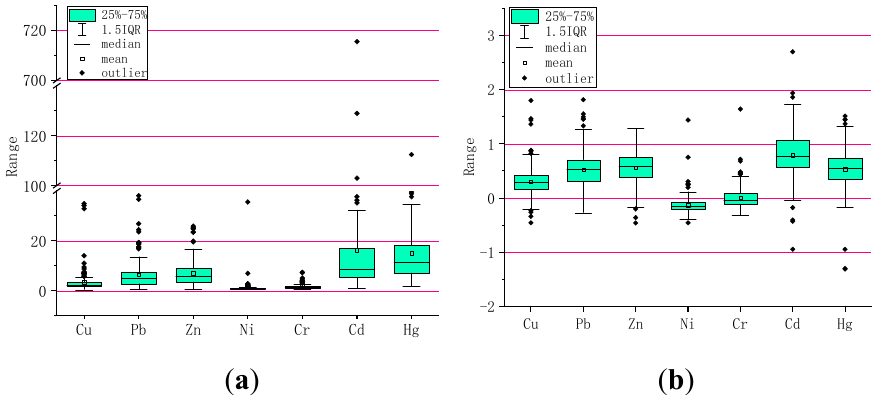
Figure 4. ( a )Enrichment factors (EF) and ( b )Geoaccumulation index (Igeo) boxplots for heavy metals Figure 4. ( a ) Enrichment factors (EF) and ( b ) Geoaccumulation index (Igeo) boxplots for heavy metals associated with dust particles smaller than 74 µm. associated with dust particles smaller than 74 µ